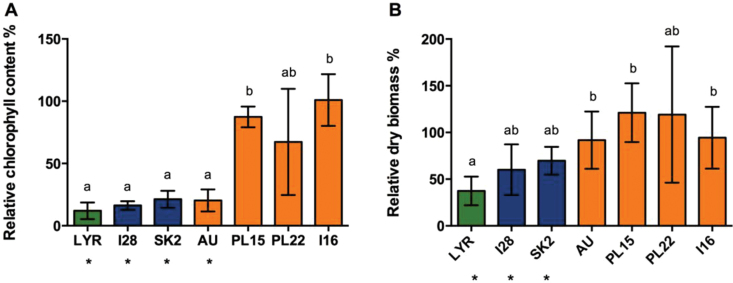
Effect of Cd on (A) chlorophyll content and (B) dry shoot biomass in hydroponically grown A. halleri NM (I28, SK2) and M (AU, PL15, PL22. I16) populations and A. lyrata petraea (LYR). Plants were cultivated for 3 weeks in a solution containing 5 μM CdSO4. Values are expressed relative to control conditions (0 μM CdSO4). Data are the mean ±SD, n=7, 10, 4, 10, 11, 7, and 16, respectively. Asterisks and letters indicate significant differences at the 5% level between treatments and among populations, respectively. (This figure is available in colour at JXB online.)